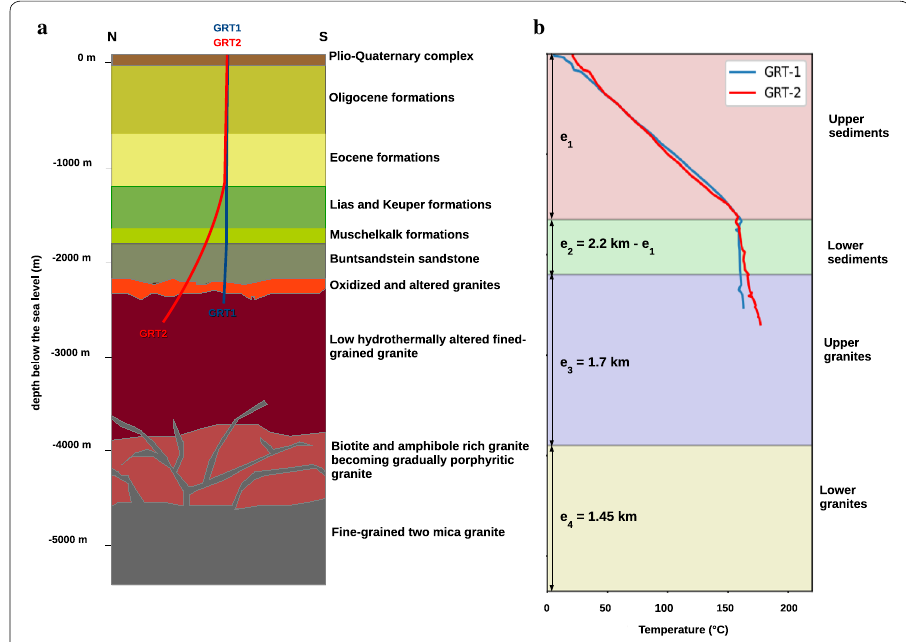
Fig. 1 a 2D conceptual model of the geology at Rittershoffen. The sedimentary cover is investigated from geological studies from Vidal et al. (2017) and Aichholzer et al. (2016). The granite below 2.5 km deep is assumed to be the same as in the Soultz-sous-Forêts site (Dezayes et al. 2005a, b). b Temperature–depth profiles obtained from logs run in the Rittershoffen wells (GRT-1, GRT-2) after drilling operation over (Baujard et al. 2017). The background colors correspond to the four layers homogenized at the scale of about 100 m and considered in the model ( e 1 , e 2 , e 3 and e 4 correspond to the layer thicknesses, e 1 is inverted during the e 2 e 3 e 2 e 3 e 4 back analysis; e 2 2.2 km - e 1 ; e 1 3.9 km ; e 1 5.4 = + + = + + + =